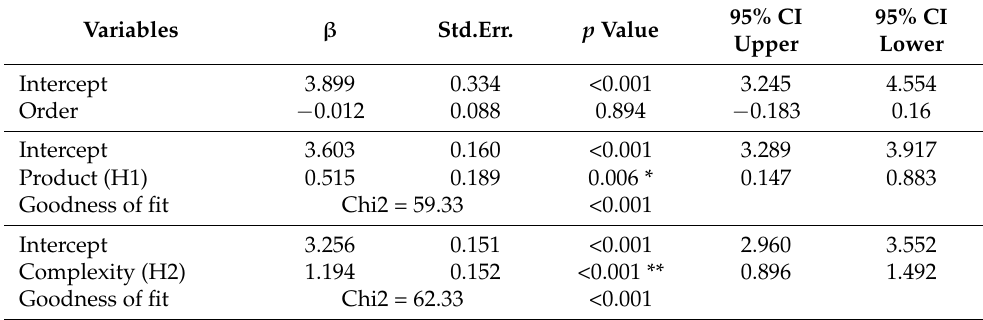
Table 4. Effects of task order, types of products, and arithmetic complexity on perceived mental